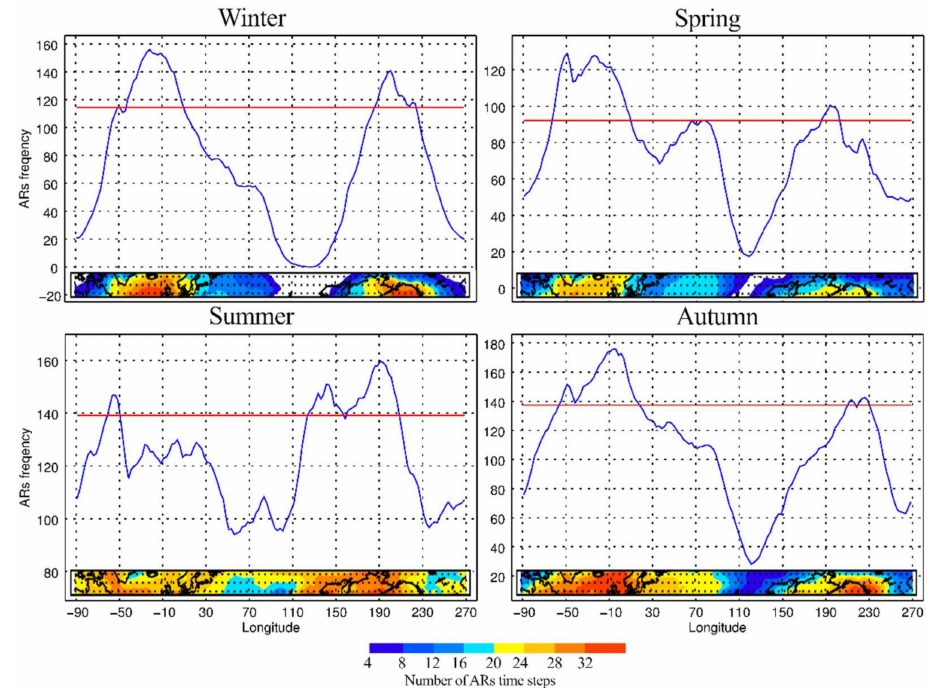
Figure 1. AR frequency over the area between 55 ◦ and 65 ◦ N over the period 1997–2014: The blue line represents the number of ARs for every longitude and the box embedded in the plot shows the spatial distribution of the ARs. Reddish colours represent areas with higher AR frequency and bluish colours those with lower. The red lines depict the 75th percentile of the